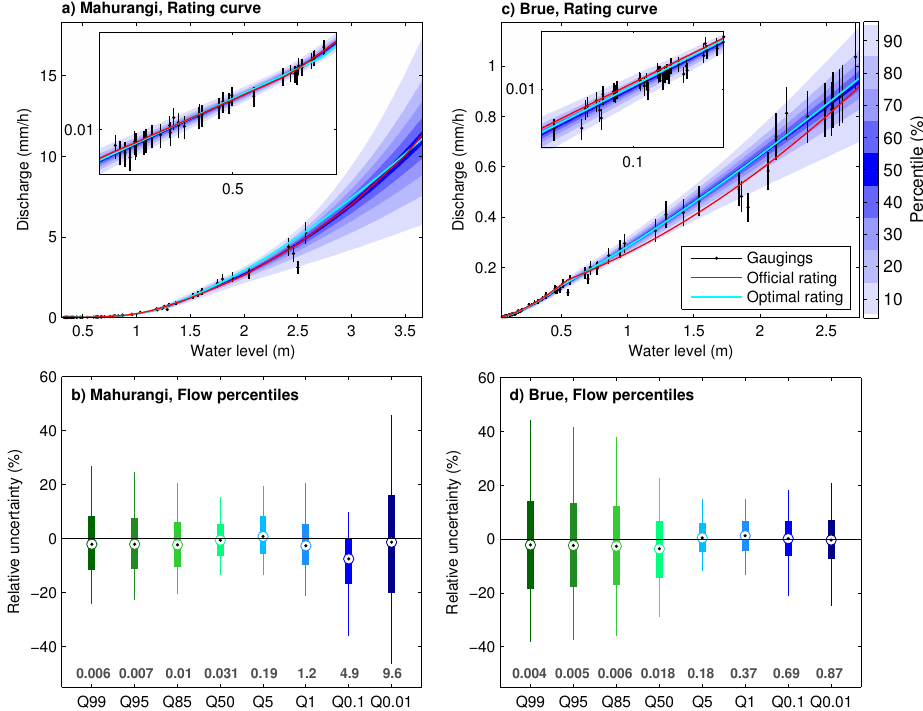
Figure 6. Estimated rating-curve uncertainty and uncertainty in flow percentiles for the Mahurangi ( a and b ) and Brue ( c and d ) catchments. Uncertainties are calculated relative to the optimal rating curve from the MCMC. For Brue the official rating curve is dissimilar to the optimal MCMC rating curve because it was calculated for a longer gauging data set starting in the 1960s, with considerably more variability. The rating curve is shown in linear space, with an inset plot in log space for the low-flow range. The flow percentiles for the optimal rating are given as hourly averages (in mmh − 1 ) at the bottom of the ( b and d ) figures. The boxplot whiskers extend to the 5 and 95 percentiles, and the box covers the interquartile